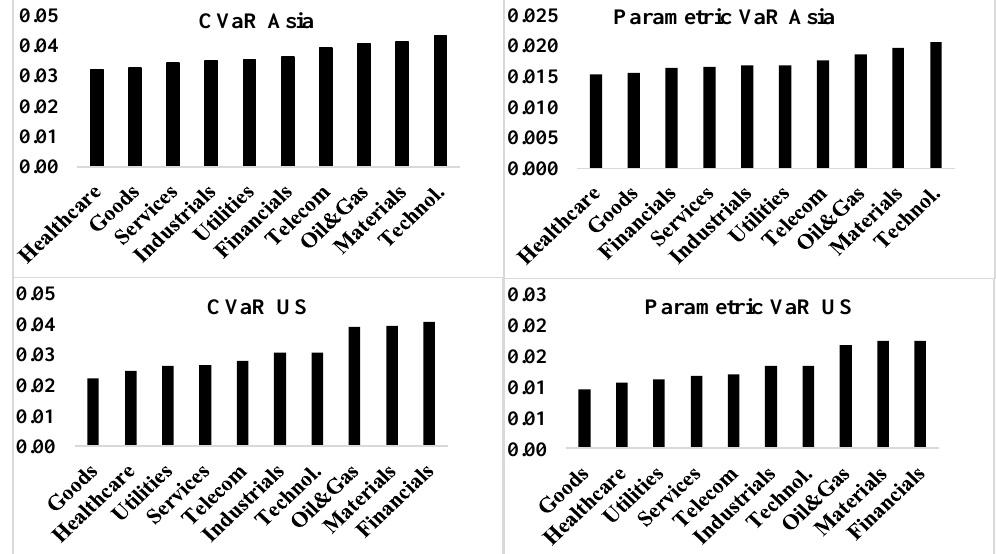
Figure 1. Total period CVaR and Parametric VaR (95%).